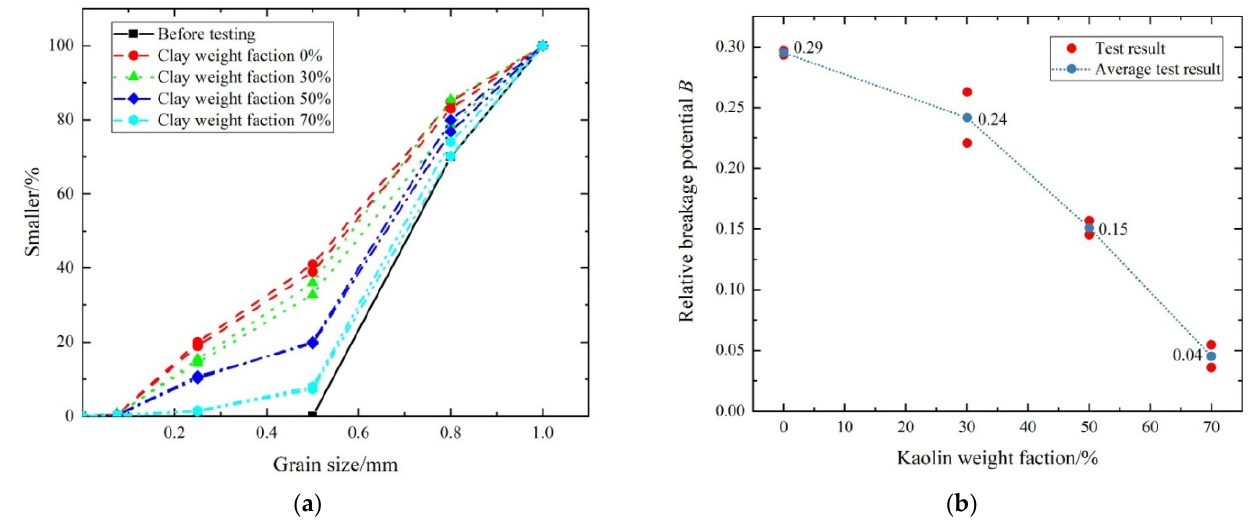
Figure 7. ( a ) Particle size distribution curves of specimens with different Kaolin weight fractions after impact. ( b ) Variation diagram of average relative breakage potential.